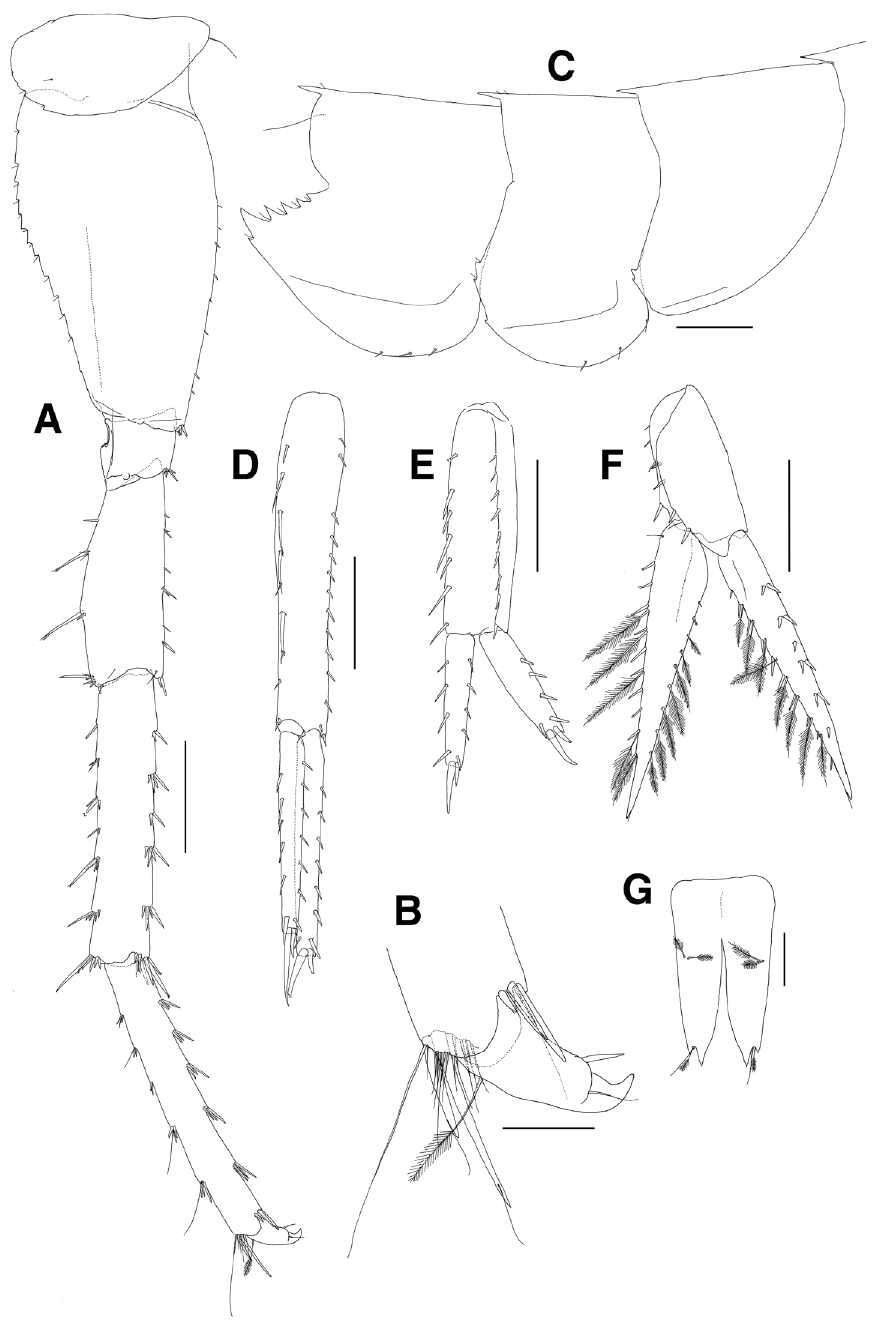
Figure 11. Paramoera dentipleurae sp. n., holotype. A Pereopod 7 B Dactylus on pereopod 7 C Pleonal epimera D Uropod 1 E Uropod 2 F Uropod 3 G Telson. Scale bars 0.05 mm ( B ), 0.1 mm ( G ), 0.2 mm ( A, C–F